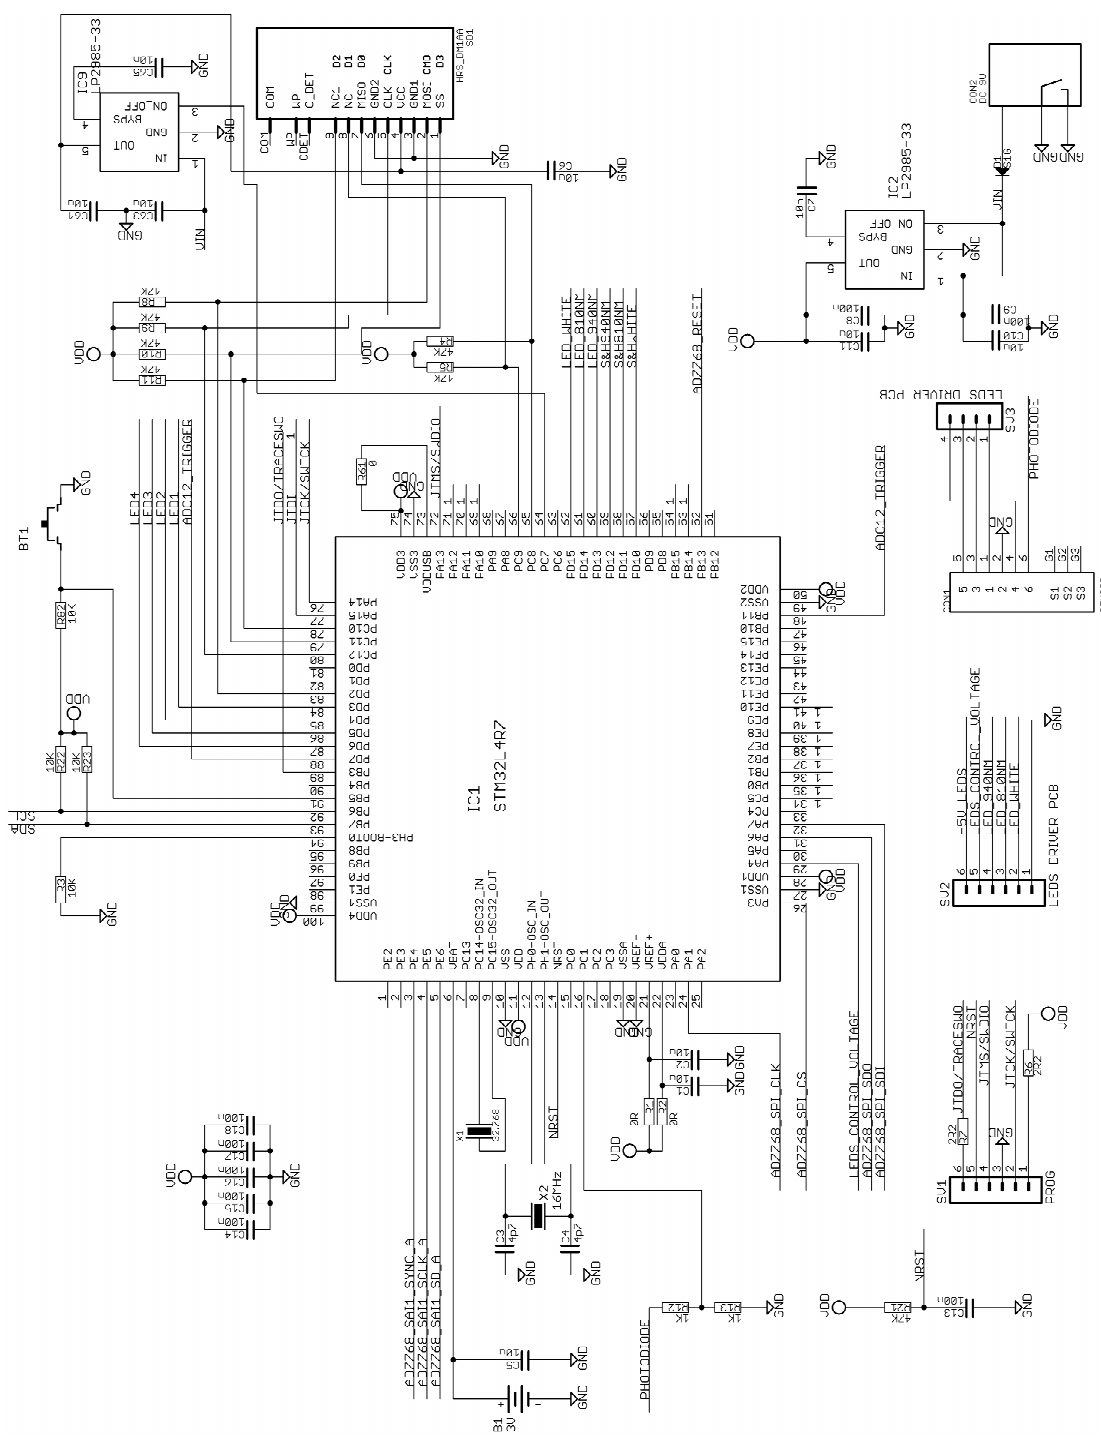
Figure A1. Microprocessor unit. The microprocessor STM32L4R7 operates at 3.3 V and is synchronized by the 16 MHz clock provided by the oscillator X2. It controls all functions of the recorder: storing at the SD card, controlling the ADC, and production of the synchronization signals. The internal real time clock is powered from battery B1 and is clocked by X1 (32.768 kHz crystal) that time-stamps detection events. The CPU also drives the LEDs and the user interface through the function button and the status LEDs, named LED1 to LED4. The connector SV1 is used for programming the CPU, and the SV2 and SV3 is used for the connection of LEDs driver PCB to main PCB. The connector CON1 is used for the connection of the sensor with the device.